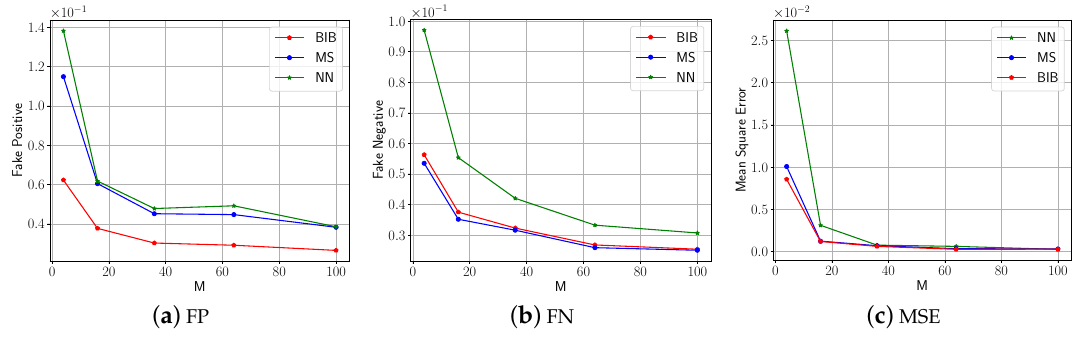
Figure 16. The average FP, FN, and MSE versus the grid numbers M for the three mentioned algorithms in the real temperature data experiment.